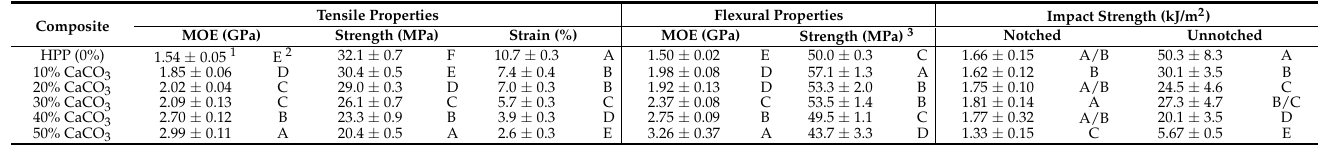
Figure 2. The tensile properties of the HPP and CaCO 3 filled HPP composites ( a ) tensile modulus of elasticity (MOE) and strength and ( b ) tensile strain at yield. Table 1. The mechanical properties of CaCO 3 particles filled HPP.